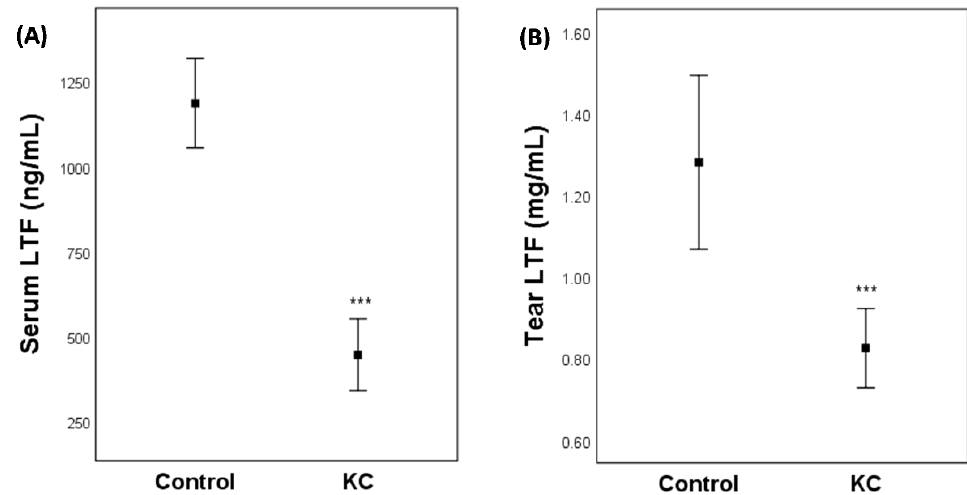
Figure 1. Serum ( A ) and tear ( B ) LTF concentrations in control subjects and KC patients. Statistical differences with regard to controls: *** p < 0.0001. Sample size: ( A ) controls = 20 eyes, KC = 40 eyes;